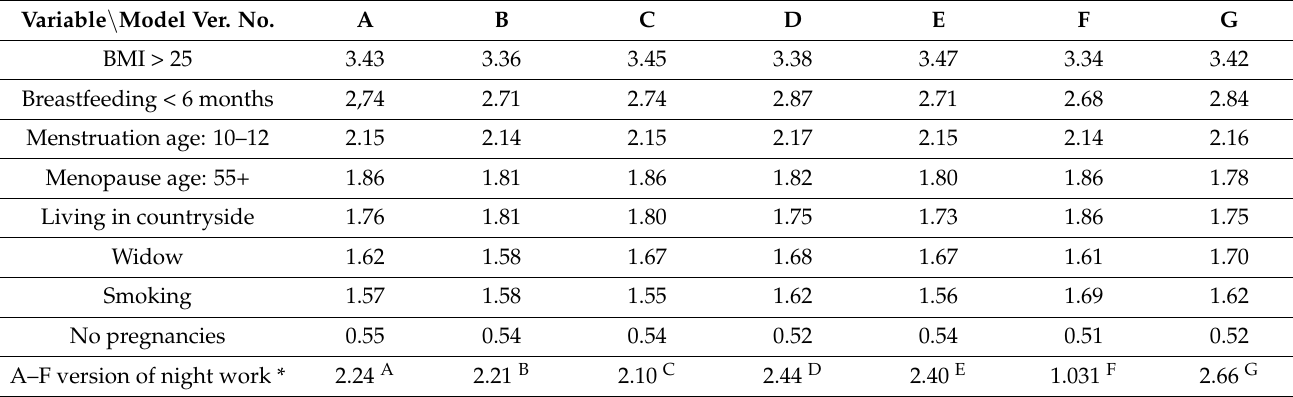
Table 3. Adjusted odds ratios of breast cancer in night workers (taking into account the intensity of night work) in the last row, with the statistically significant ORs for confounding factors in rows above the last one. Variable \ Model Ver.